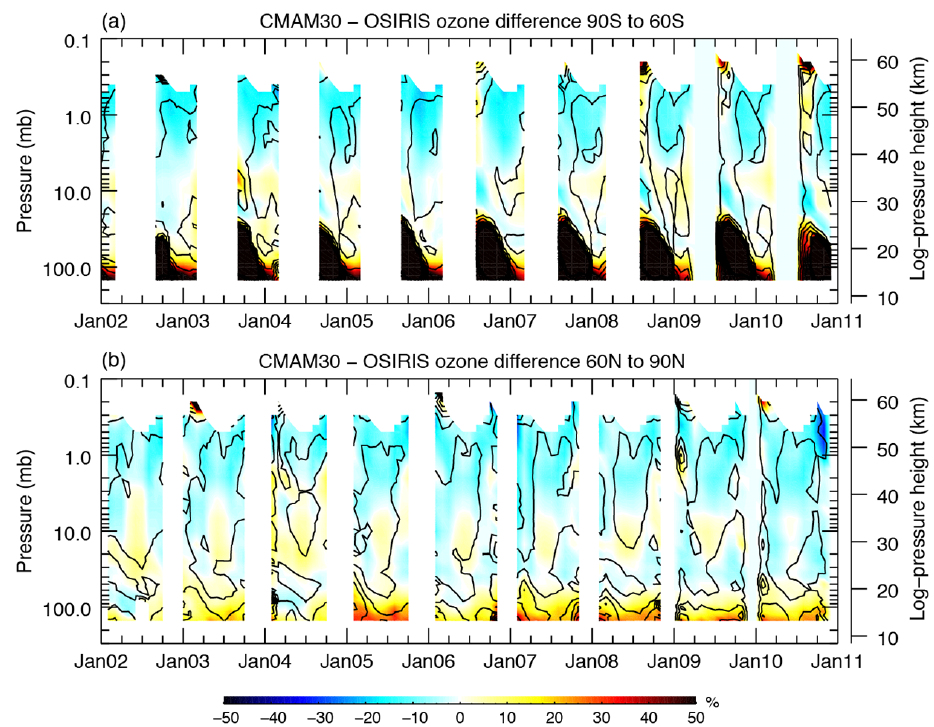
Figure 8. Same as for Fig. 7 but for time series of relative differences between CMAM30 and OSIRIS ozone. Colours indicate the median bias, and contours indicate the MAD with a contour interval of